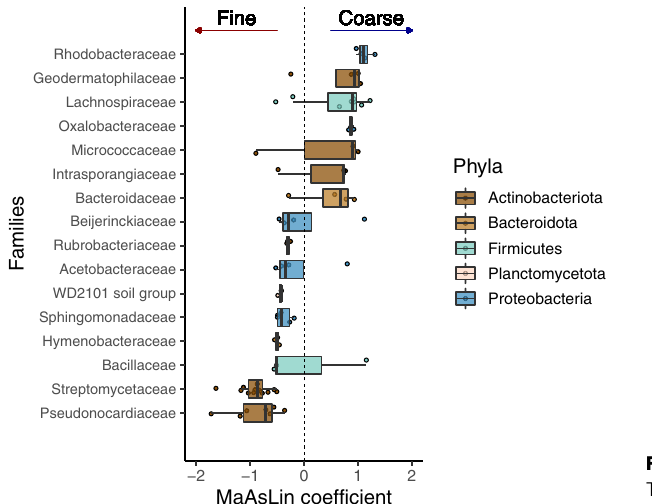
Fig. 4 Bacterial taxa signi fi cantly associated with coarse particle-size class compared with fi ne particle-size class. The MaAslin2 scores per family is presented with association to fi ne and coarse particle sizes. Each color represents a different phylum. Box plot center lines represent the median values, the lower and upper hinges correspond to the fi rst and third quartiles (the 25th and 75th percentiles), the lower and upper whisker extends from the hinge to the lowest and largest value no further than 1.5 * IQR from the hinge, and dots represent ASVs within each group. Bacterial families with more than two ASVs associated with one of the particle-size are shown.